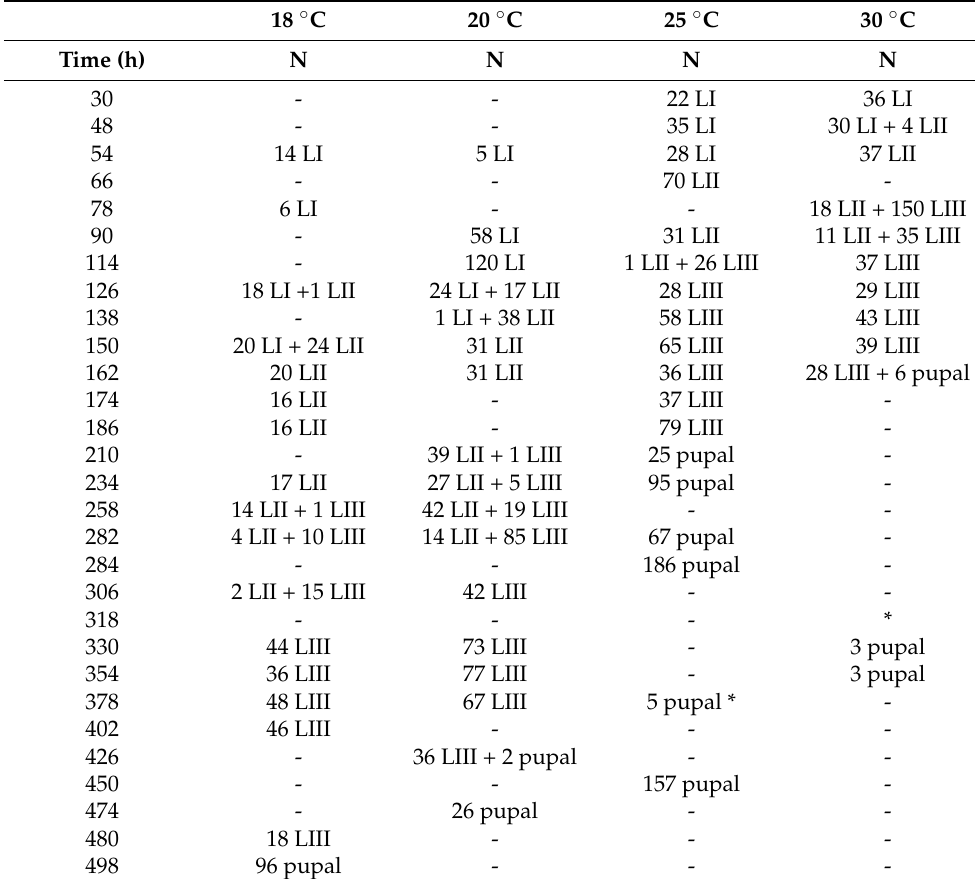
Table A1. Number of specimens of H. capensis (N) and stage (L-I, L-II, L-III and pupal) mapped to different sampling intervals (hours) at different constant